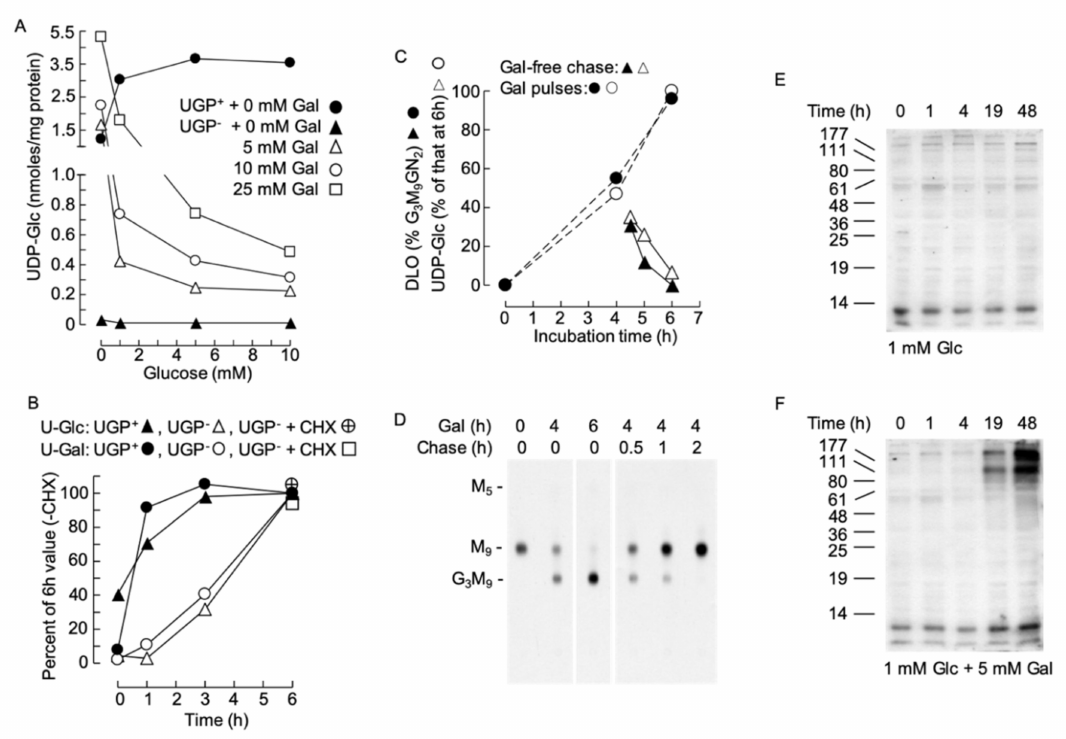
Figure 7. ( A ). UGP + and UGP − cells were grown as described above prior to being treated for 6 h with glucose-free medium to which the indicated additions of glucose and galactose were made. UDP-Glc was measured as described above. ( B ). UGP + and UGP − cells were cultivated for 4 days in normal growth medium prior to incubating the cells, for the indicated times, with glucose-free medium to which 1 mM Glc and 5 mM Gal were added. In one experiment the cells were pretreated for 30 min with 10 µ g / ml cycloheximide (CHX). UDP-Glc ( U-Glc ) and UDP-Gal ( U-Gal ) were measured as above. The quantities of these nucleotide sugars have been expressed as a percentage of the quantity found to occur at the 6 h time point in the absence of CHX. All data points represent a single determination. ( C , D ). UGP − cells were grown in normal growth medium for 4 days, washed in glucose-free RPMI 1640 and then incubated for the indicated times in this medium containing 1 mM Glc + 5 mM Gal (Gal). Where indicated, the cells were then rinsed with glucose-free RPMI 1640 prior to being incubated for the indicated times in normal growth medium (chase). Subsequent to these incubations, UDP-Glc was measured. The observed UDP-Glc levels have been expressed as a percentage of that occurring at 6 h of Gal treatment. All data points represent a single determination. In a parallel experiment, cells were radiolabeled with [2- 3 H]mannose for 30 min and DLO were extracted and examined by thin-layer chromatography ( D ). The fluorograph shown in D was scanned densitometrically and the percentage of total DLO occurring as Glc 3 Man 9 Glc N Ac 2 was computed. F. UGP − cells were incubated for up to 48 h in the indicated media. After harvesting, the galactosylation of cellular proteins was examined by RCA lectinoblot as described for Figure 4A. This is a representative experiment, and in another experiment, a control membrane, where the blot was incubated with RCA-I in the presence of 500 mM lactose, revealed that detection of bands was sugar dependent (as demonstrated in Figure